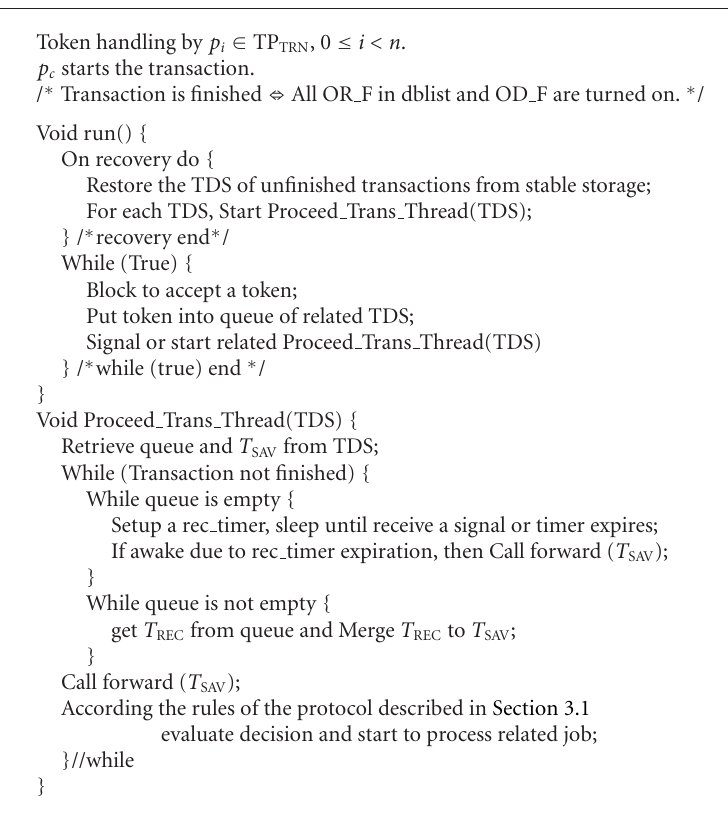
Algorithm 2: Behavior of a